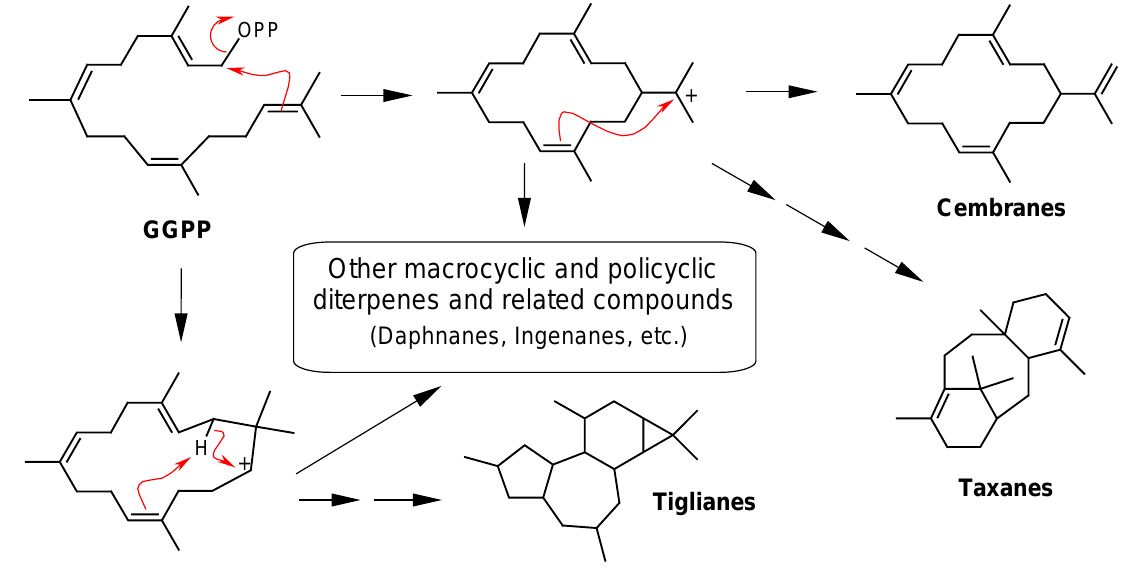
Figure 1. Cyclization of geranylgeranyl pyrophosphate (GGPP) with the pyrophosphate group (-OPP) acting as a nucleofuge (leaving